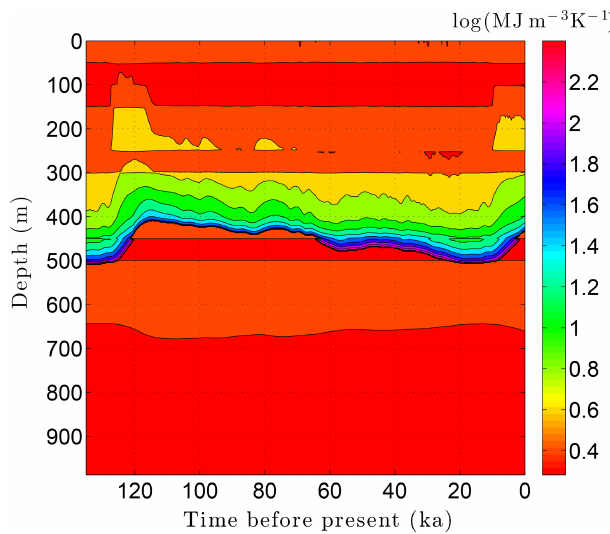
Figure 11. Volumetric heat capacity C variations over the last ice- age cycle within the example sedimentary sequence (Fig. 8). The color mapping corresponds to log (C) .